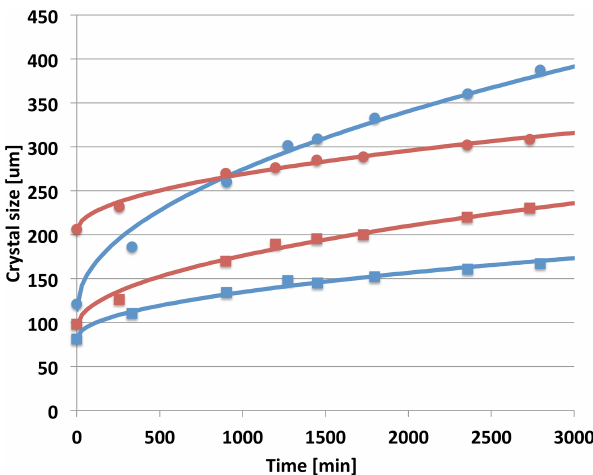
Figure 6. Crystal dimensions a(t) (circles) and c(t) (squares) mea- sured during part B of the experiment for the crystals shown in Fig. 5. Blue points are for the crystal on C f and the red points are for the crystal on C r . The lines are the best fit for each crystal to a two-parameter power-law parameterization a(t) = a 0 + g a × t 1 / 2 and c(t) = c 0 + g c × t 1 / 2